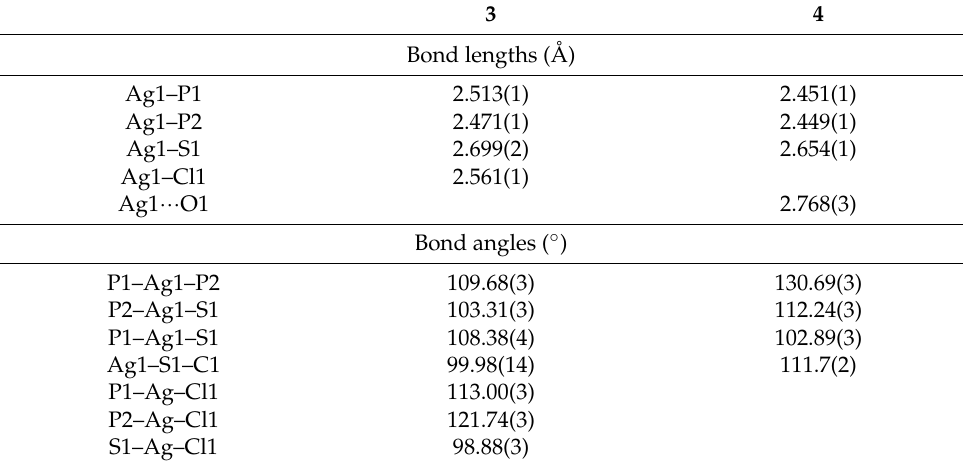
Table 1. Selected bond lengths (Å) and angles ( ◦ ) for 3 and 4